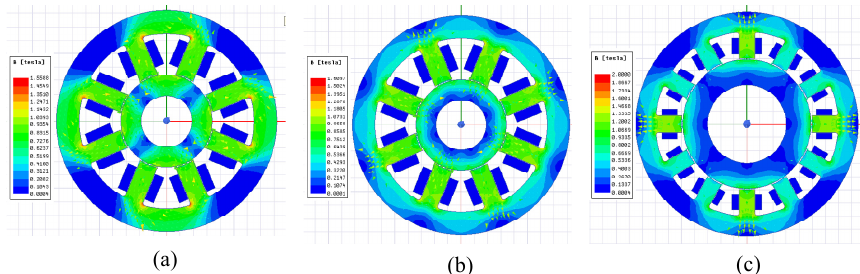
Figure 12. Magnetic field analysis of 8 ‐ pole and 12 ‐ pole RMBs. ( a ) Finite element analysis of 8 ‐ pole C ‐ type structure. ( b ) Finite element analysis of 8 ‐ pole NSNS pole structure. ( c ) Finite element anal ‐ C-type structure. ( b ) Finite element analysis of 8-pole NSNS pole structure. ( c ) Finite element analysis ysis of 12 pole E ‐ type structure. of 12 pole E-type